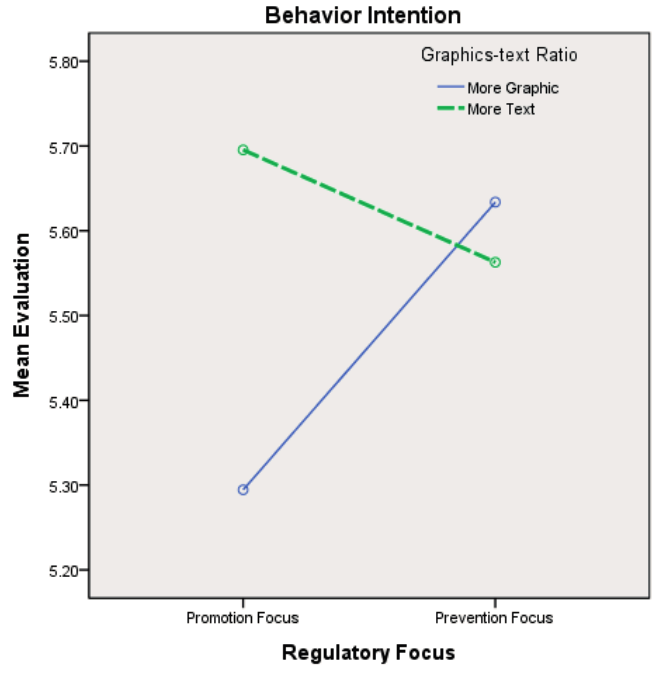
Figure 7. Interaction effects between regulatory focus and the graphics-text ratio on behavior